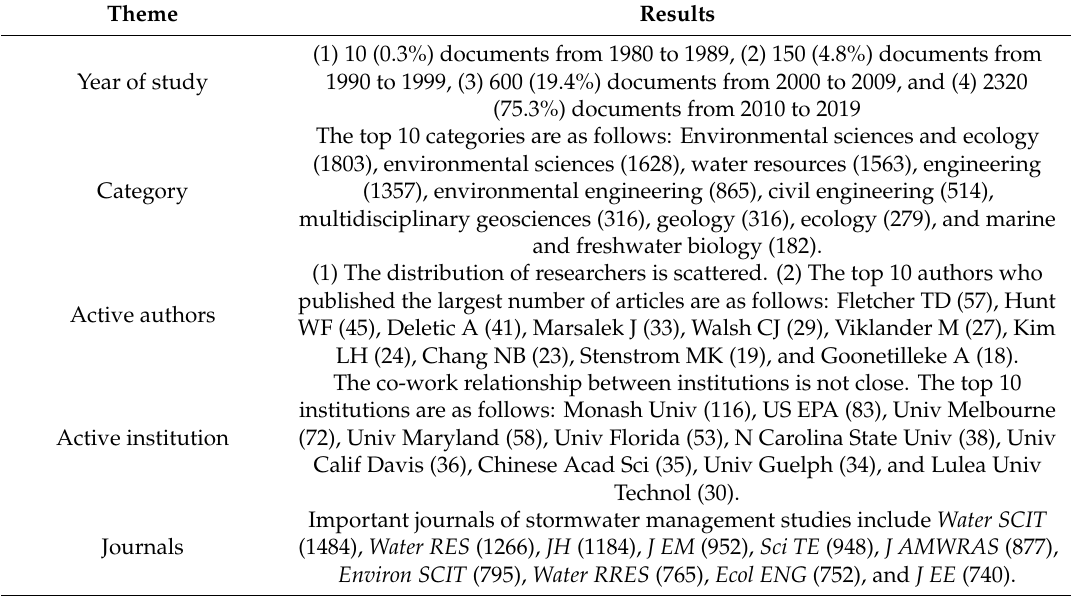
Table 2. Number of documents, institutions, disciplines, and